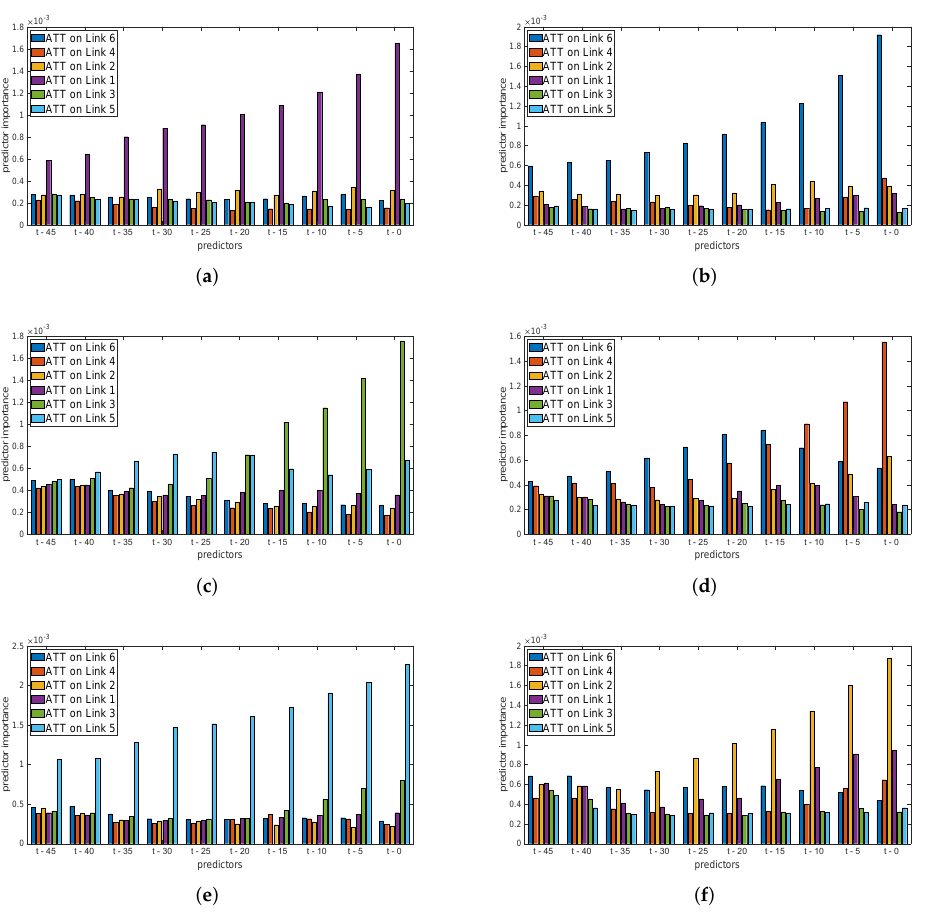
Figure 3. Predictor importance in classifiers with a 5-min prediction horizon on Mondays and ATT input features up to t − 45 min. ( a ) Link 1. ( b ) Link 6. ( c ) Link 3. ( d ) Link 4. ( e ) Link 5. ( f ) Link